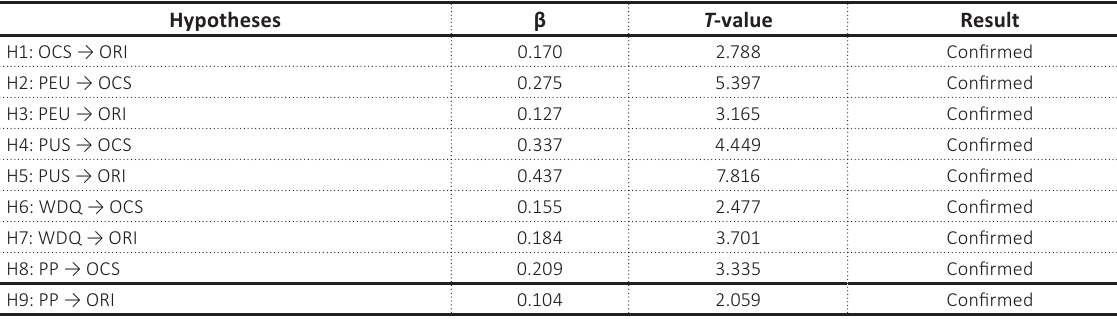
Table 6. Hypotheses